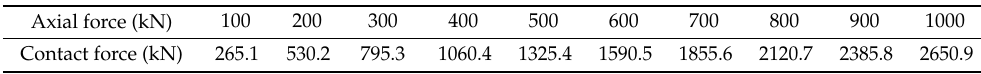
Table 3. Contact force between slips and slip-seat under different axial